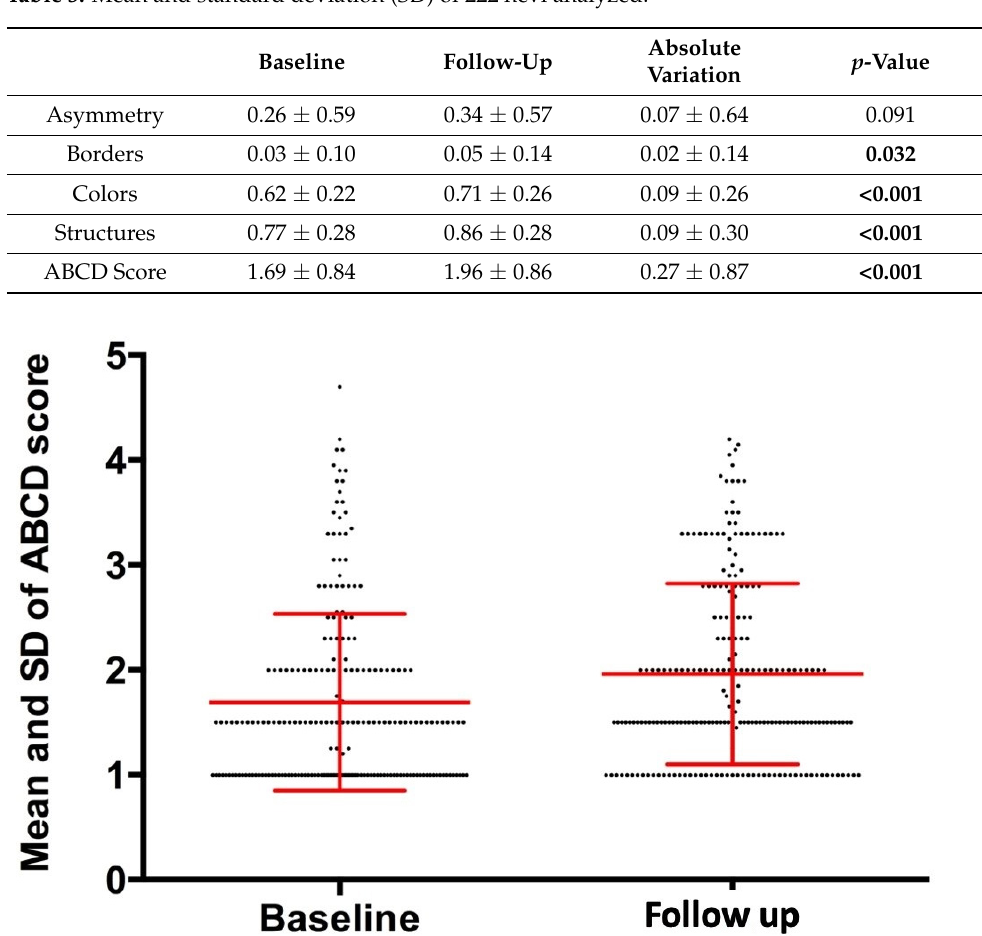
Figure 2. Mean and standard deviation (SD) of ABCD Score at baseline and